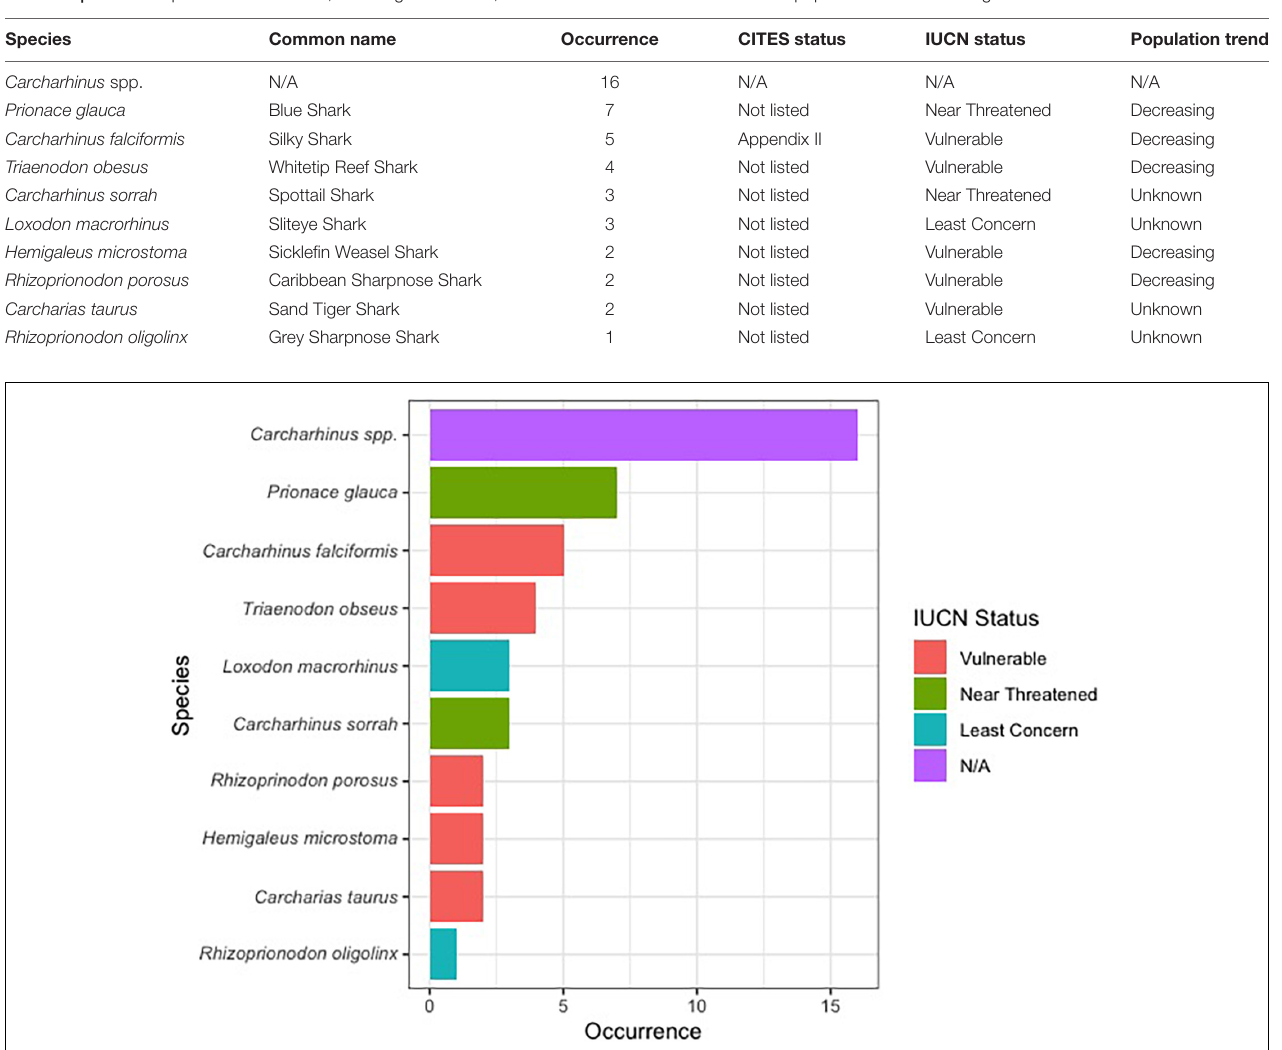
FIGURE 1 | Bar plot showing the proportion of shark species identified in this work along with their IUCN red list status.